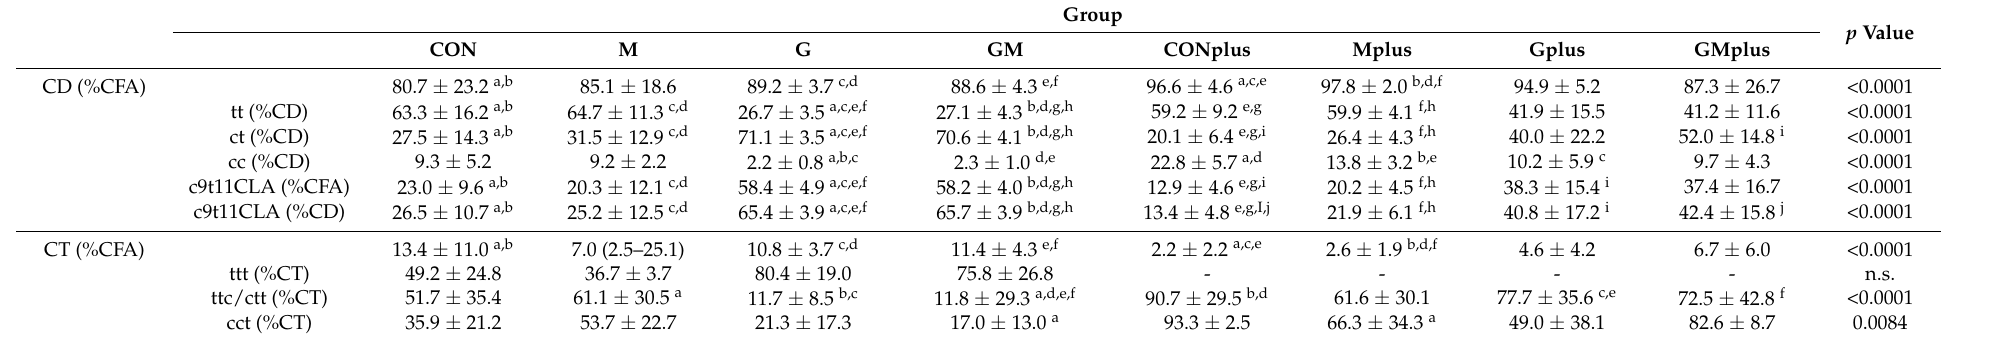
Table 3. Profiles of geometrical CFA isomers in hepatic microsomes of experimental